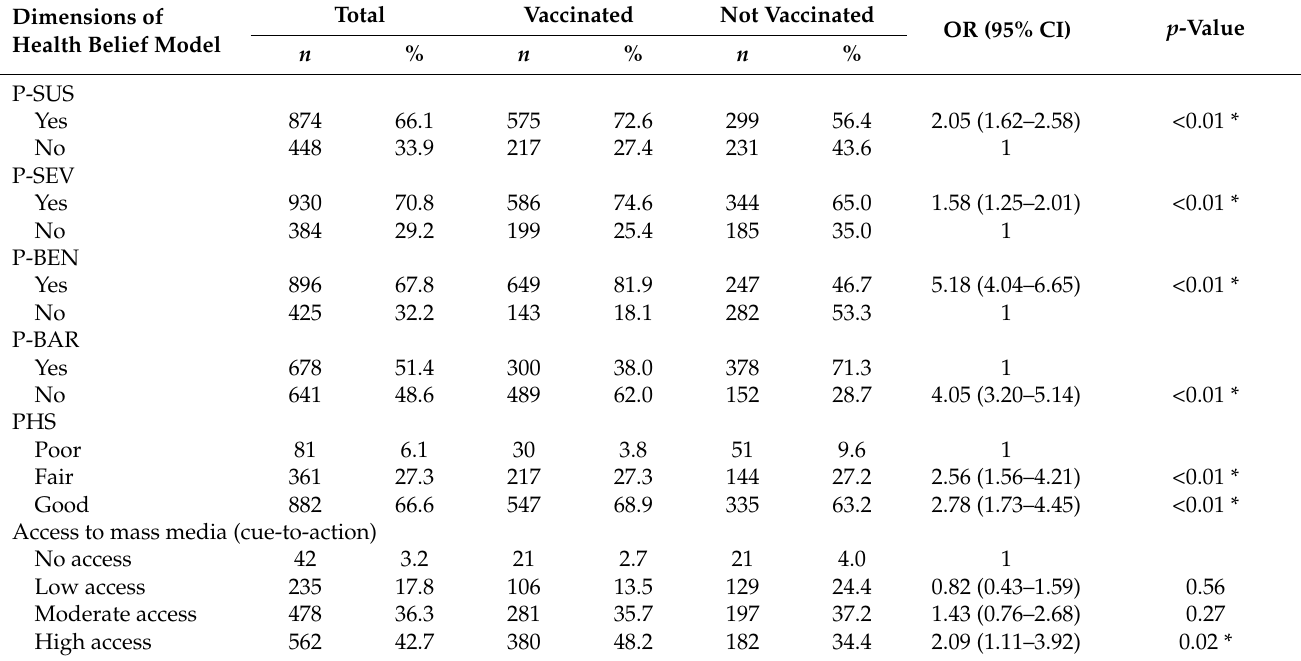
Table 3. HBM and vaccination